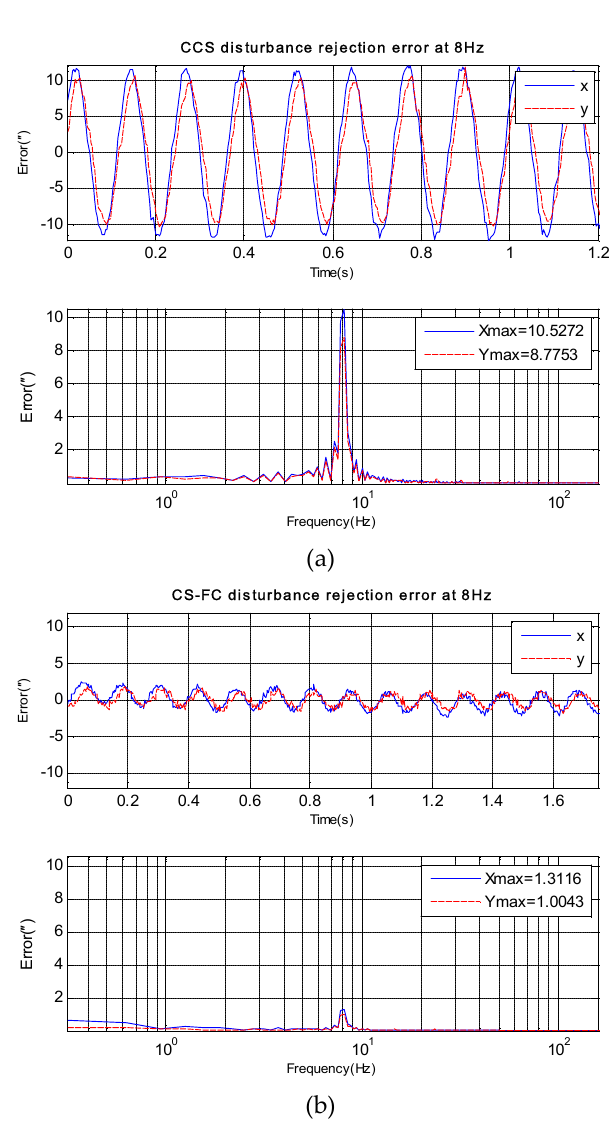
Figure 6. X -axis and Y -axis disturbance rejection error at 8 Hz. ( a ) disturbance rejection error of CCS; ( b ) disturbance rejection error of CS-FC.